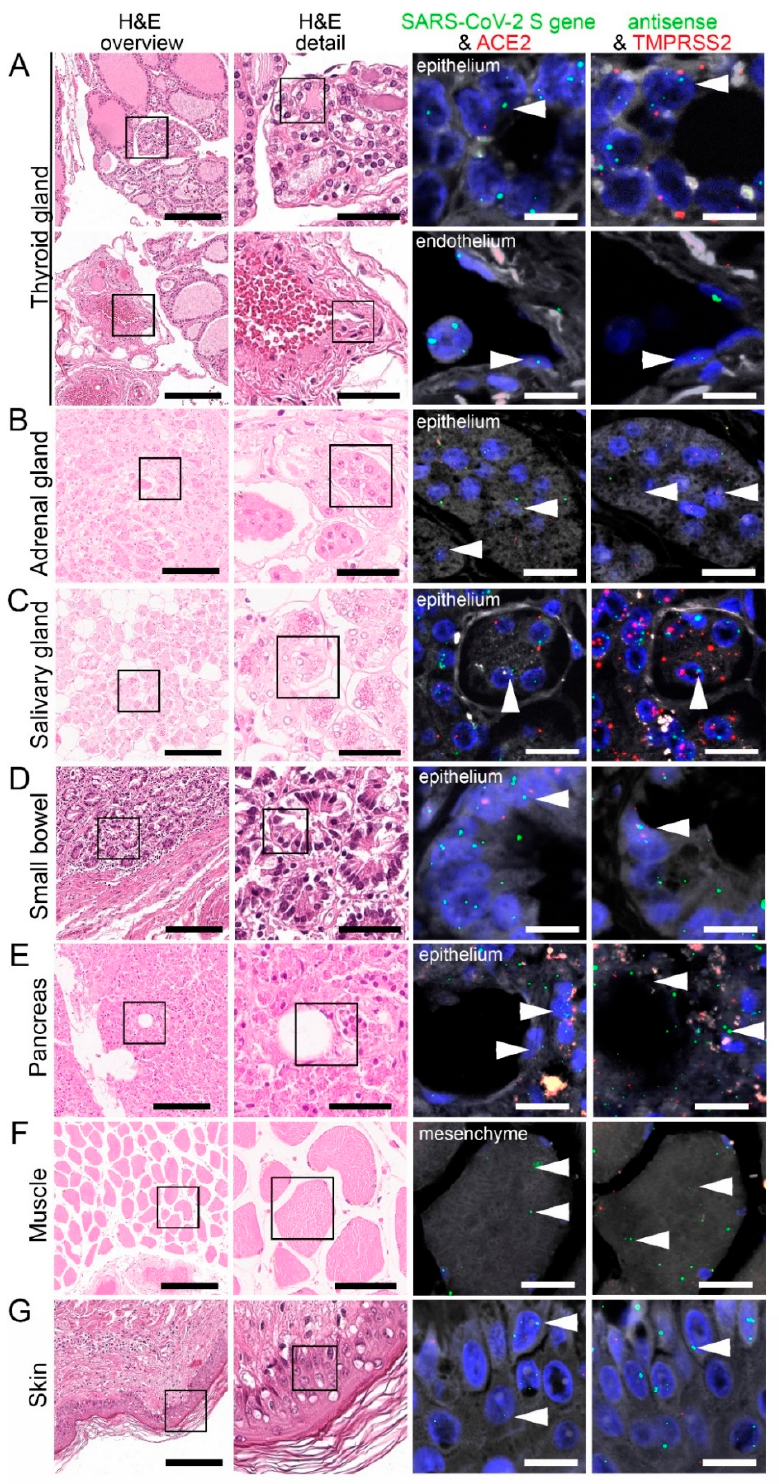
Figure 7. Virus detection in endocrine and gastrointestinal organs and skeletal muscle autopsy tissue by FISH. HE stained tissue and representative image sections showing FISH co-visualization of RNA sequences either of SARS-CoV-2 S gene genomic RNA (green, arrowhead) and ACE2 (red) or SARS-CoV-2 antisense strand RNA indicating replicating virus (green, arrowhead) and TMPRSS2 (red) in the thyroid ( A , upper panel: follicular epithelium; lower panel: vascular endothelium), adrenal gland ( B , glandular epithelium), salivary gland ( C , acini), small bowel ( D , crypt epithelium), pancreas ( E , acinar epithelium), skeletal muscle ( F , skeletal muscle cell) and skin ( G ). Scale bars represent 200, 50 and 10 µm ( A , C , F ) or 20 µm ( B , D , E ), respectively.